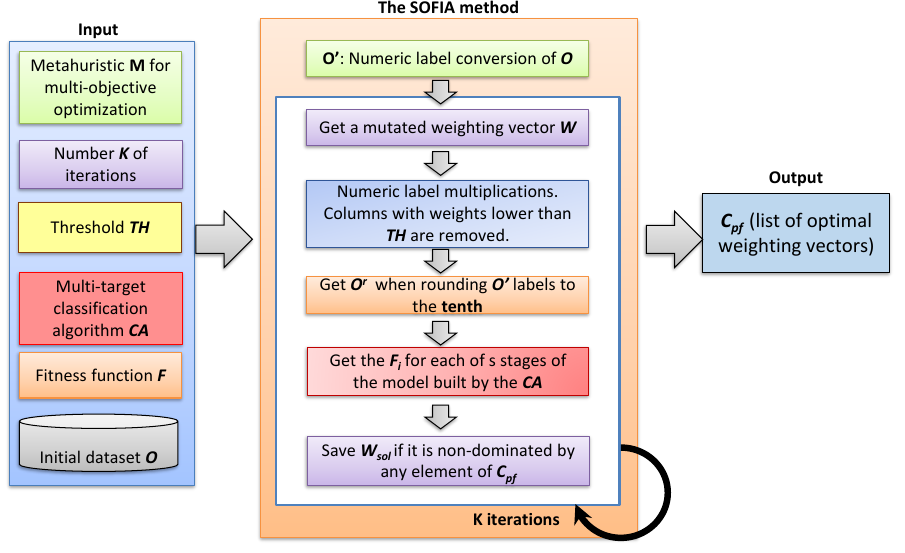
Figure 1. Diagram of the Selection Of medical Features by Induced Alterations in numeric labels (SOFIA)